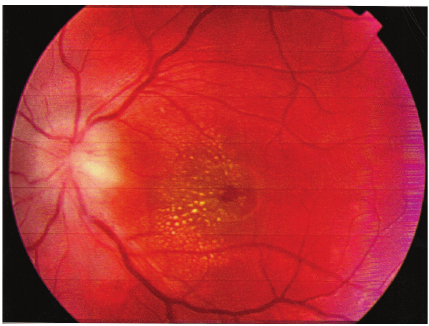
Figure 1: Left eye retinography at the time of admission: papillede- ma and macular star